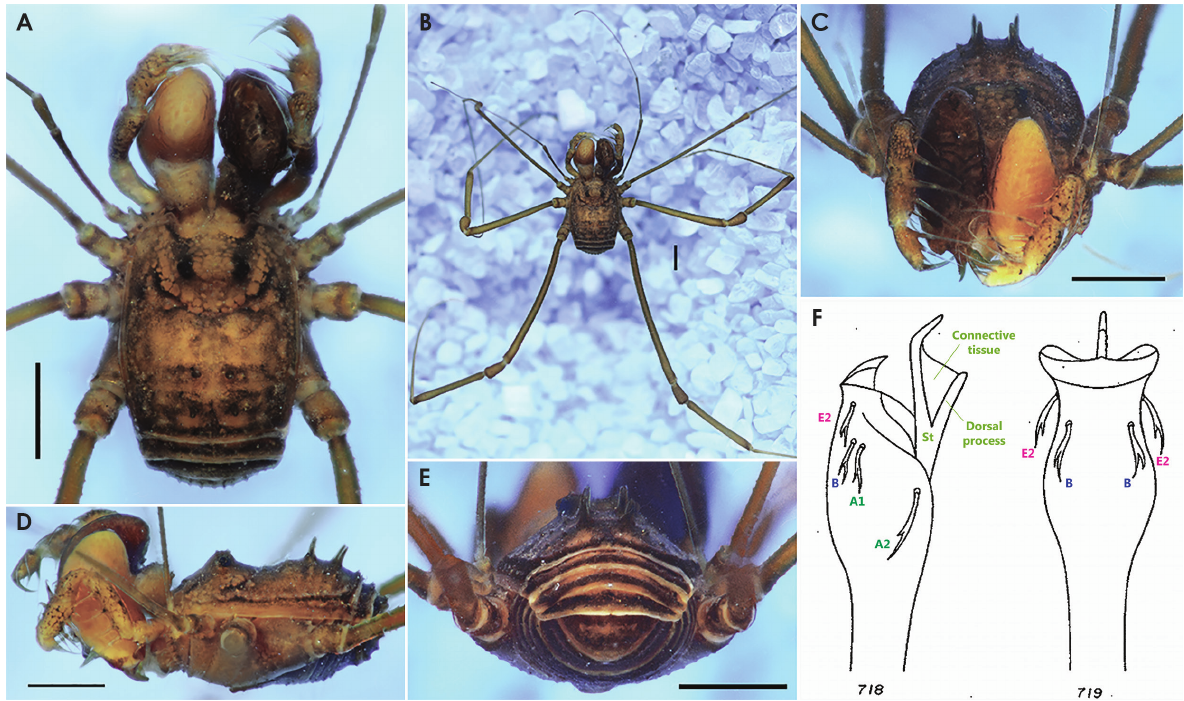
Figure 3. Barinas virginis (González-Sponga, 1987) comb. nov. (MAGS 852), male. Habitus in dorsal ( A ), panoramic ( B ), frontal ( C ), lateral ( D ), and posterior ( E ) views. Penis drawings ( F ) of holotype (MCNC 981) (González-Sponga, 1987: 550, figs 718–719), lateral and ventral views (modified to show the chaetotaxy system of Kury and Villarreal (2015)). Scale bars: 1 mm. Photos courtesy of Osvaldo Villarreal.